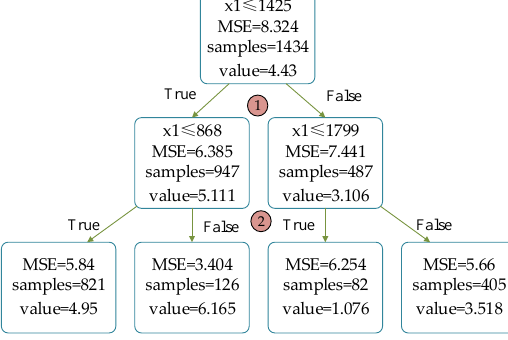
Figure 6. Process of building a gradient decision tree.